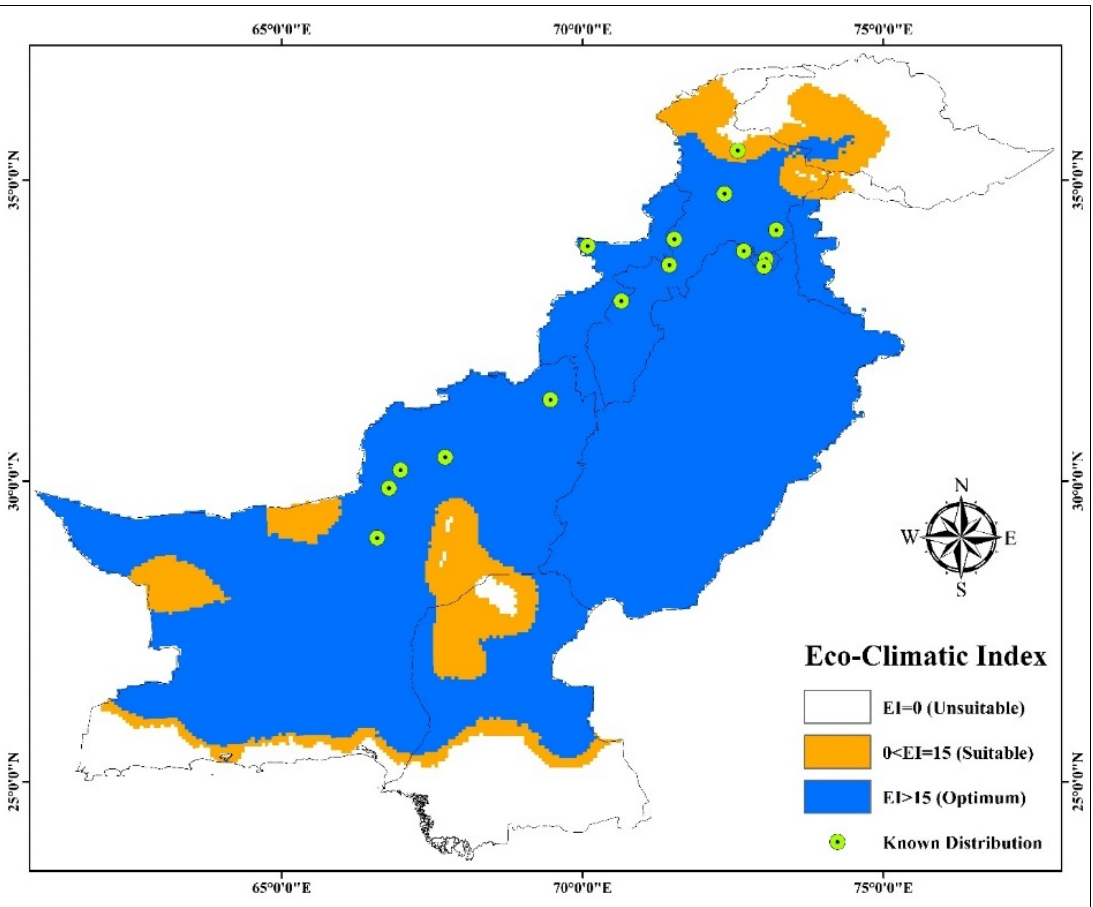
Figure 2. Potential distribution of Aeolesthes sarta in Pakistan under historic climatic conditions. Blue color indicates optimum habitat (EI > 15), orange color indicates suitable habitat (0 < EI = 15), white color indicates unsuitable habitat (EI = 0), and green circles indicate the current known distribution of A. sarta in Pakistan.